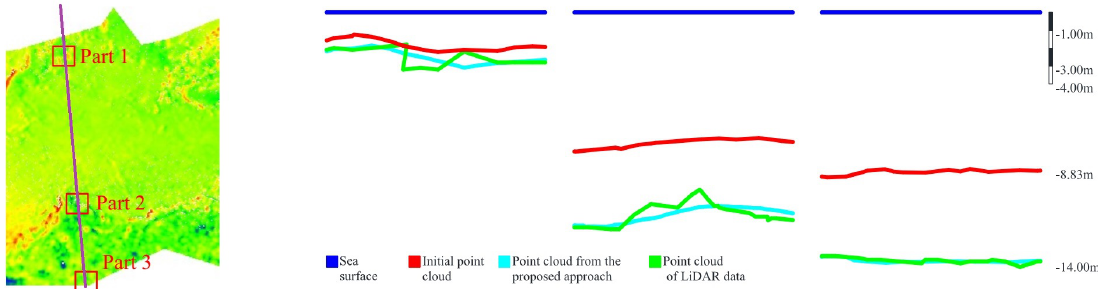
Figure 9. Indicative cross-sections (X and Y axis having the same scale) from the Agia Napa (Part I) region after the application of the proposed approach when trained with 30% from the Part II region. The blue line corresponds to water surface while the green one corresponds to LiDAR data. The cyan line is the recovered depth after the application of the proposed approach, while the red line corresponds to the depths derived from the initial uncorrected image-based point